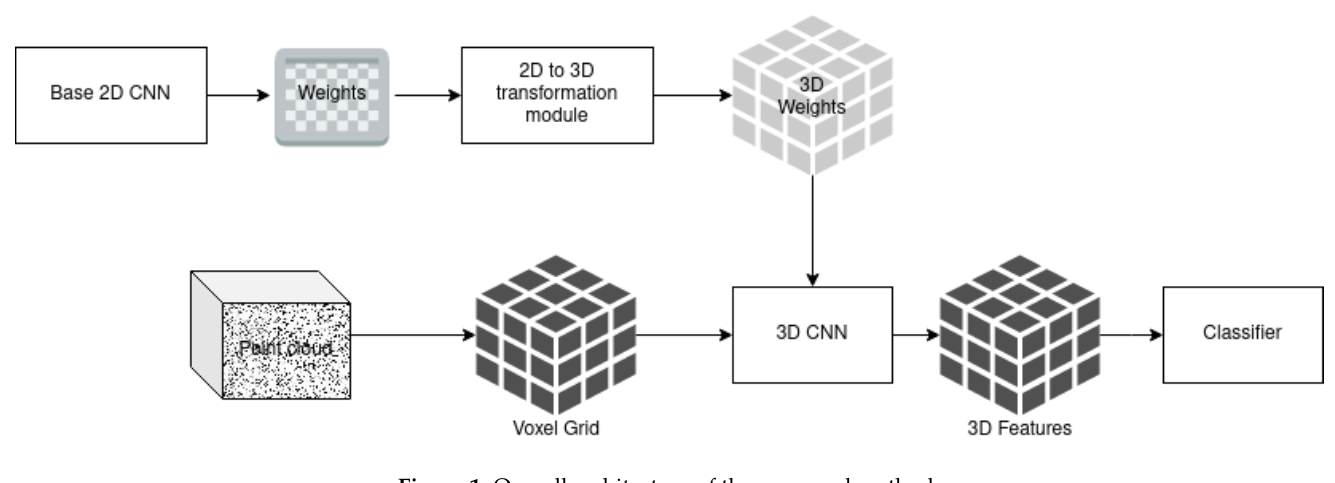
Figure 1. Overall architecture of the proposed method.